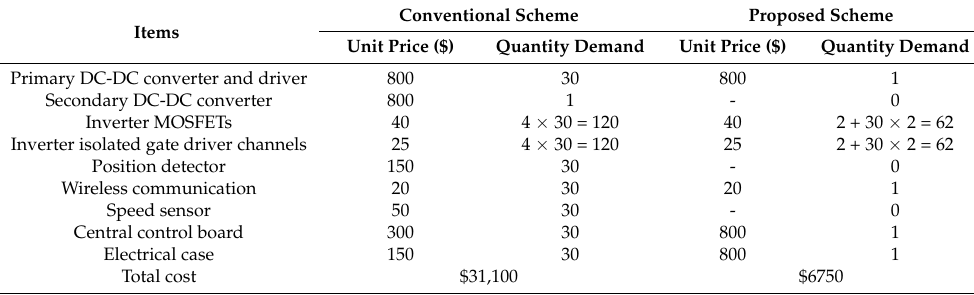
Table 4. Cost comparison for the two